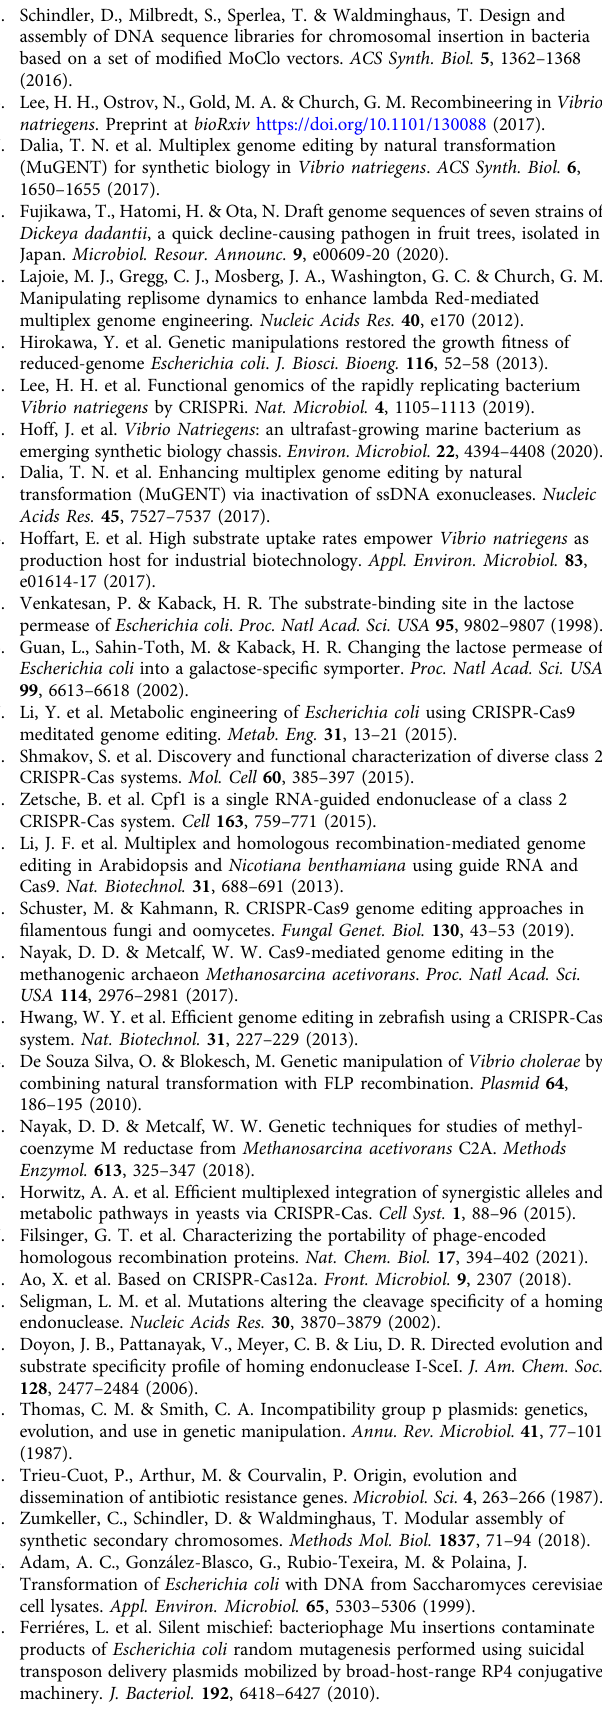
Supplementary Information/Source data fi le. Plasmid maps and cloning templates for pSwap construction can be found in the supplementary data. Source data are provided with this